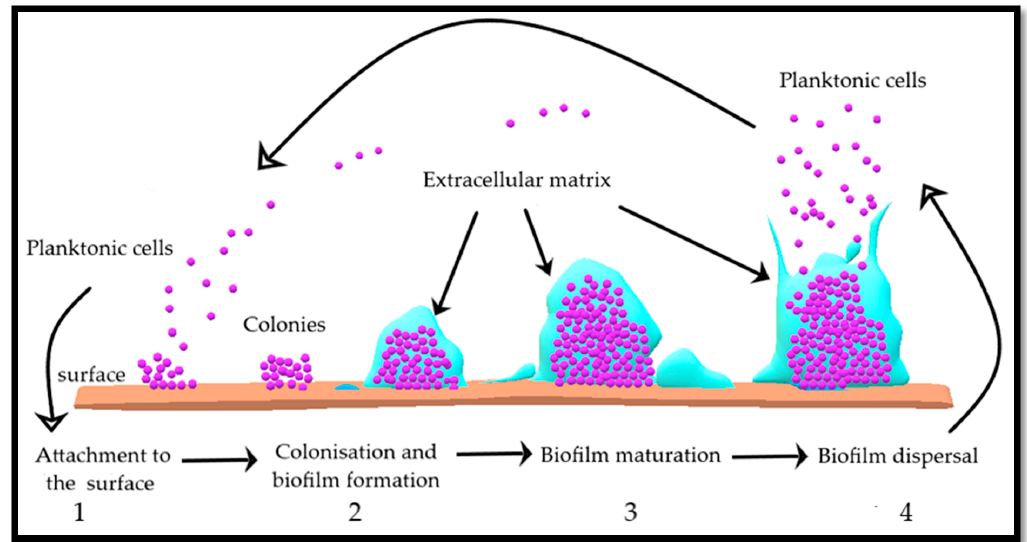
Figure 10. The different stages of microbial biofilm formation are as follows 1) attachment of cells